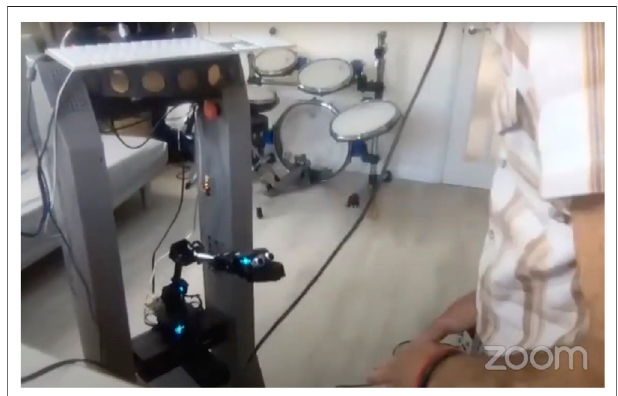
FIGURE3| Ascreengrab fromanonlineperformanceofEMRv4andthe author as part of the Art-AI festival